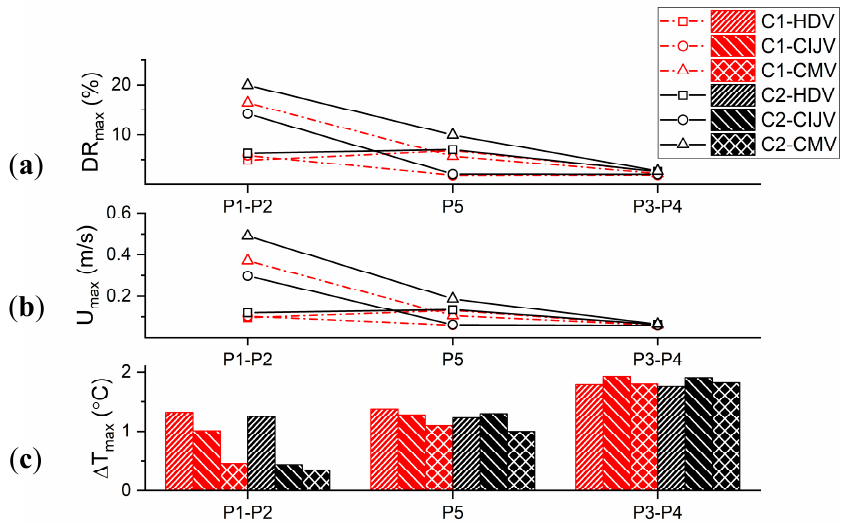
Figure 6. Maximum draught rate ( a ), maximum velocity ( b ) and maximum temperature difference ( c ) in positions P1–P2, P5 and P3–P4.